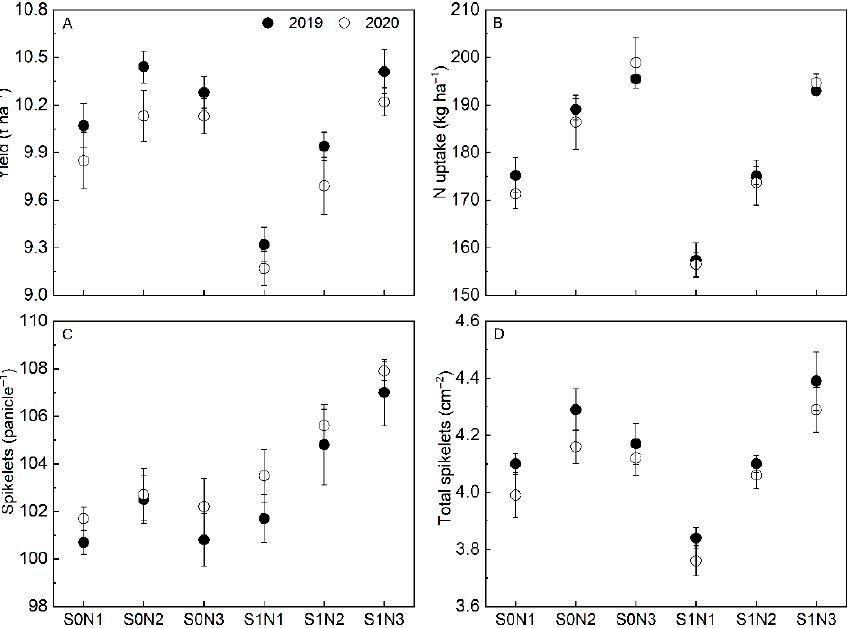
Figure 2. Yield ( A ); N uptake ( B ); spikelets per panicle ( C ); and total spikelets number ( D ) for all treatment combinations in 2019 and 2020. S0 and S1 represent treatment without wheat straw returning and treatment with wheat straw returning, respectively. N1, N2, and N3 represent early N treatments was shown in Table 1. Error bars show standard error of replicates ( n = 3).